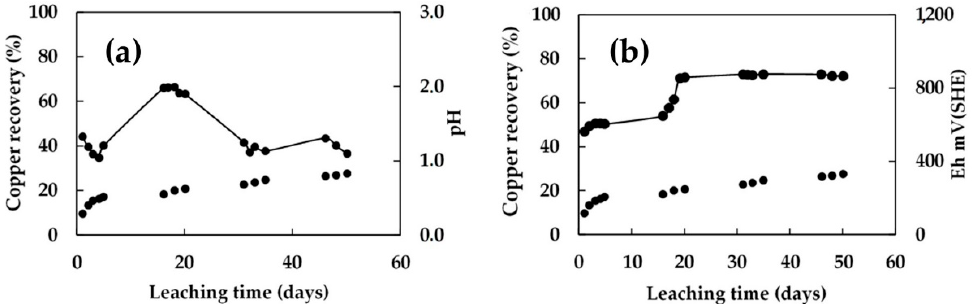
Figure 8. Copper dissolution ( • ) from chalcopyrite ore in 10 g/L acid (pH 1.0), 0.5 g/L copper (II), and 1.5 × 10 8 cells/mL from the second cycle at ambient temperature with three intermittent irrigation cycles of 5/10 days. ( a ) Variation in pH (dashed line); ( b ) variation in Eh (dashed